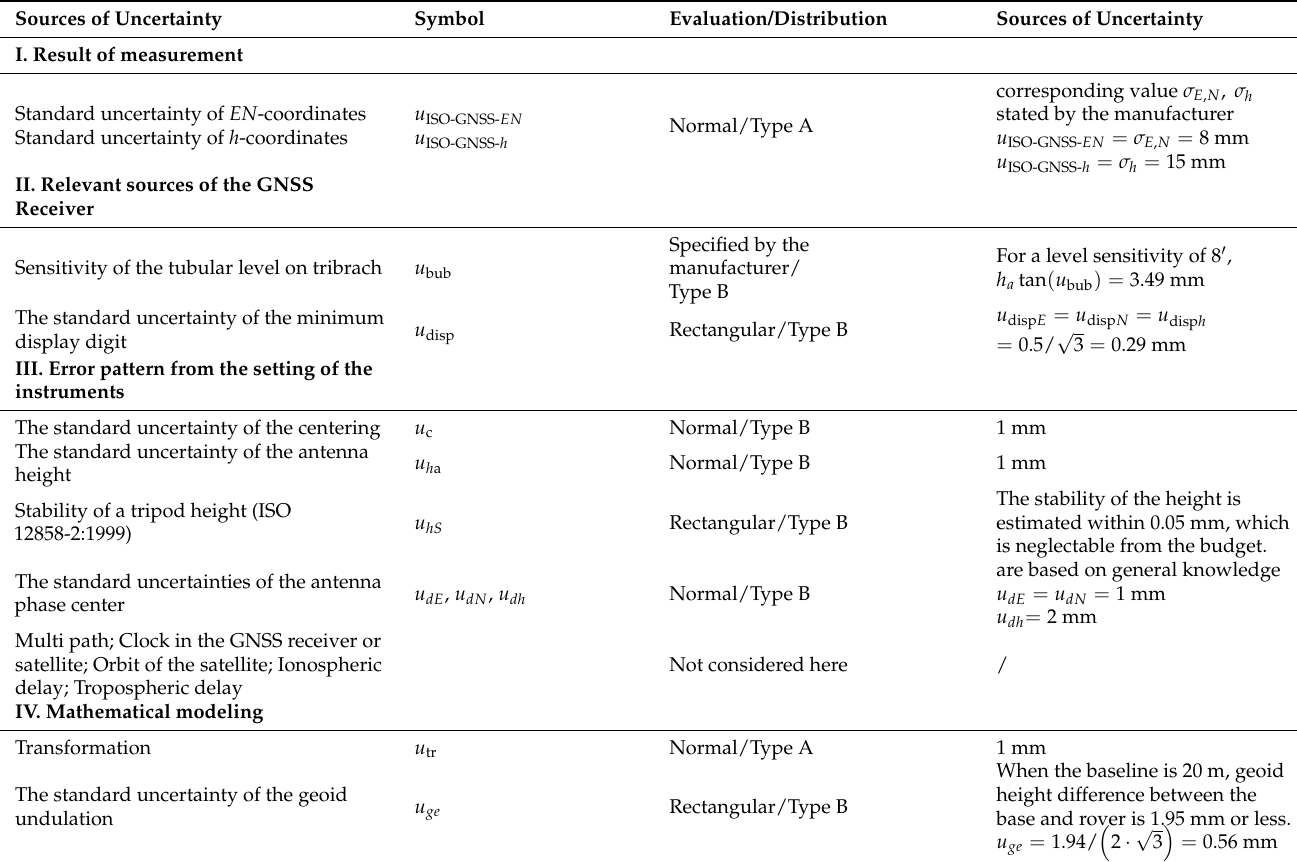
Table 6. Typical influence quantities of the GNSS (RTK) [17]—Taken over from ISO 17123-8:2015, Table